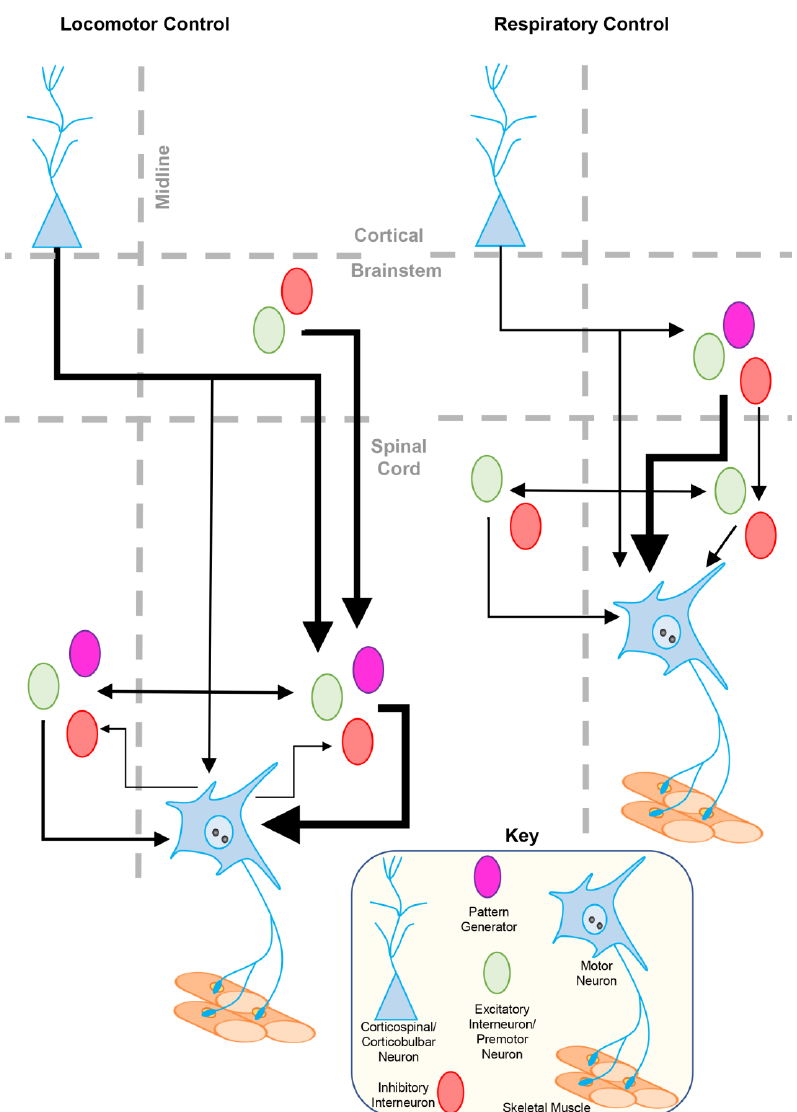
Figure 1. Locomotor and respiratory neuromotor control. In the case of locomotor control, there are corticospinal influences (blue pyramidal neurons) and bulbospinal influences on spinal cord central pattern generators (purple), and inhibitory (red) and excitatory (green) premotor neurons. These segment-level neurons coordinate motor outputs of the ipsilateral and contralateral side via projections. Ipsilateral and contralateral inhibition via circuits formed from recurrent motor axons also provides for coordination within these segments. In the locomotor system, the major inputs to motor neurons (blue neurons innervating skeletal muscle fibres) come from ipsilateral pattern and premotor neurons within the spinal cord segment. For respiratory neuromotor control, pattern generation and premotor excitatory and inhibitory circuits reside primarily in the brainstem, projecting to ipsilateral phrenic motor neurons. There are some segment-level premotor inputs to motor neurons; however, all pattern generation necessary for breathing resides in the brainstem, with a modicum of cortical modulation for a variety of post-inhibitory behaviours (e.g.,